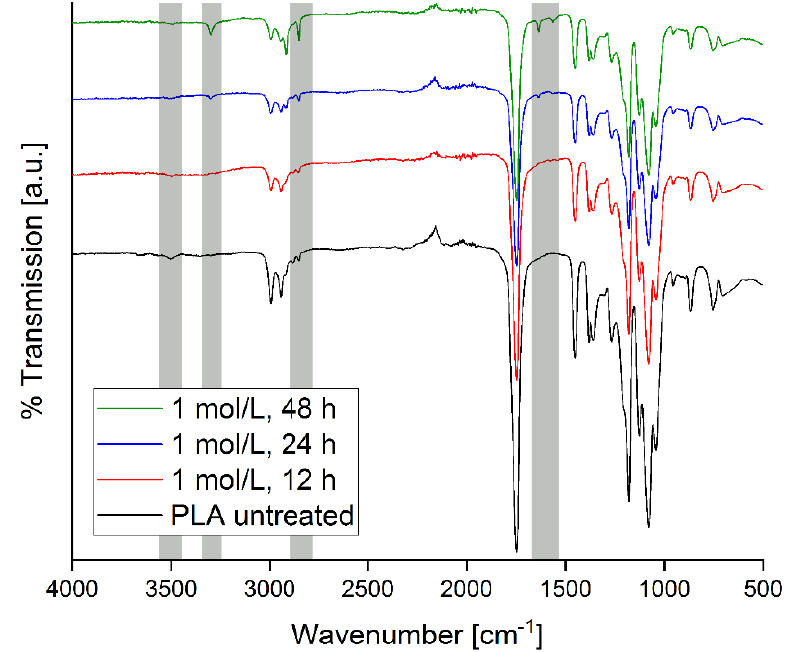
Figure 4. IR-Spectra obtained from untreated PLA and from PLA treated with 1.0 mol / L NaOH for 12, 24, and 48 h. Grey areas indicate regions of most important spectral changes.